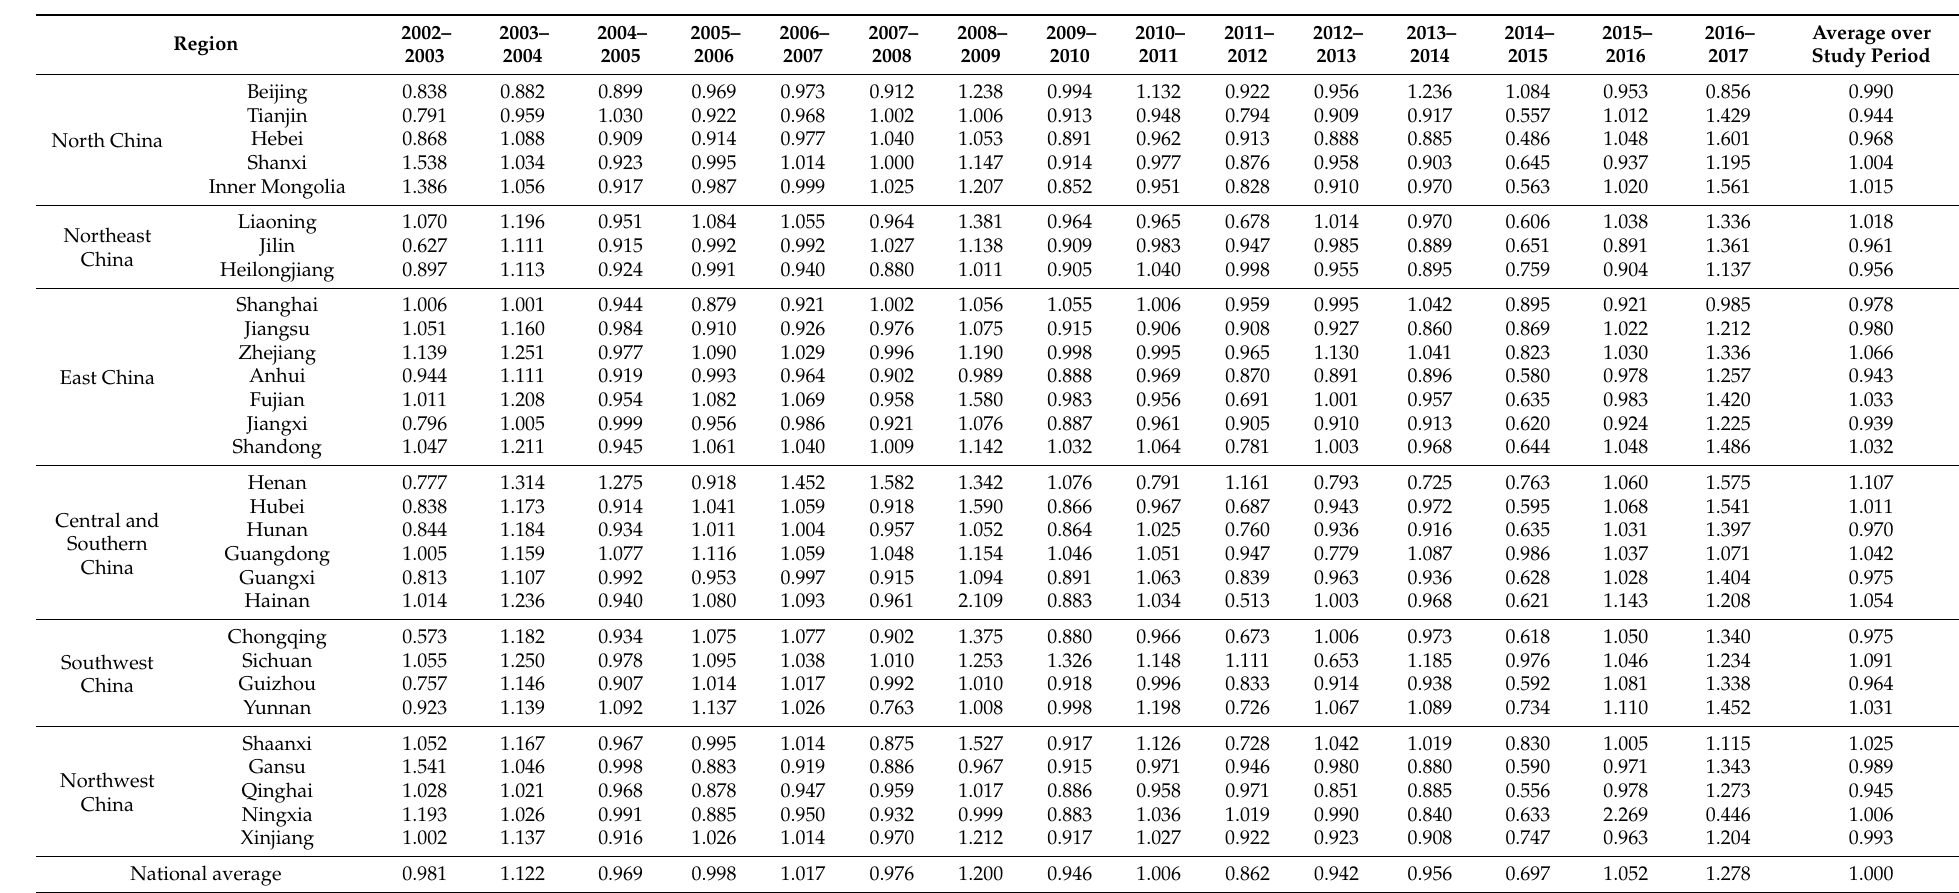
Table A5. Changes of bootstrapped TCI over